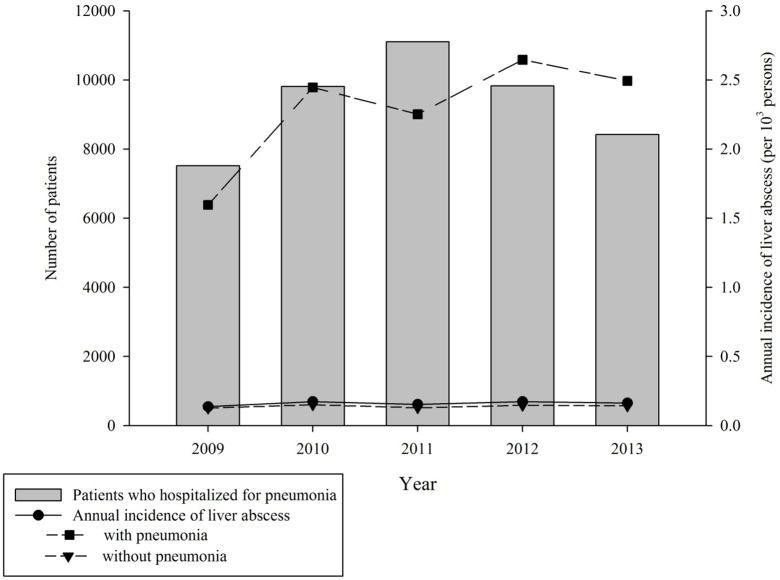
Annual incidence of pyogenic liver abscess (PLA) in 2009–2013.